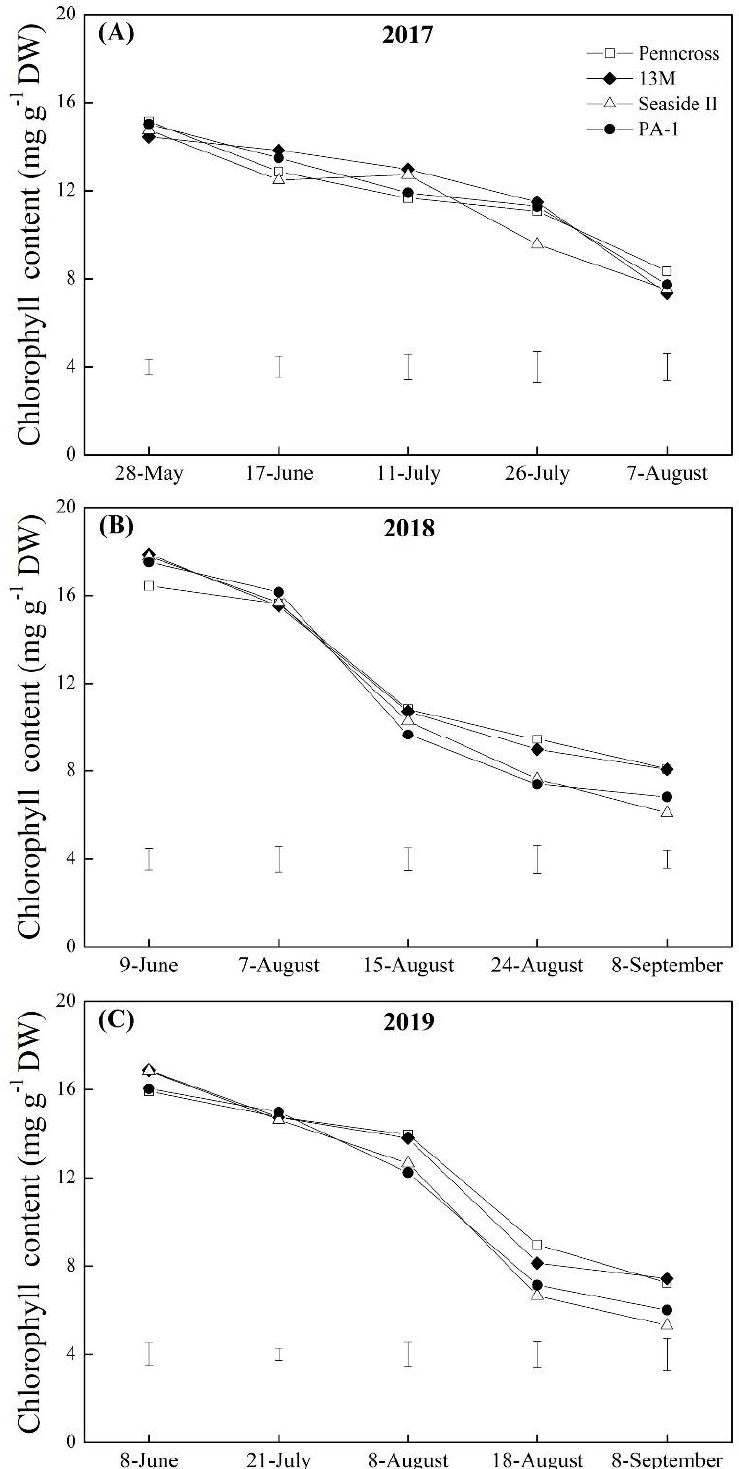
Figure 3. Change in chlorophyll (Chl) content of four different creeping bentgrass cultivars (Penncross, 13M, Seaside II, and PA-1) during summer in ( A ) 2017, ( B ) 2018, and ( C ) 2019. Vertical bars below curves indicate least significant difference (LSD) values ( p < 0.05) at a given day.